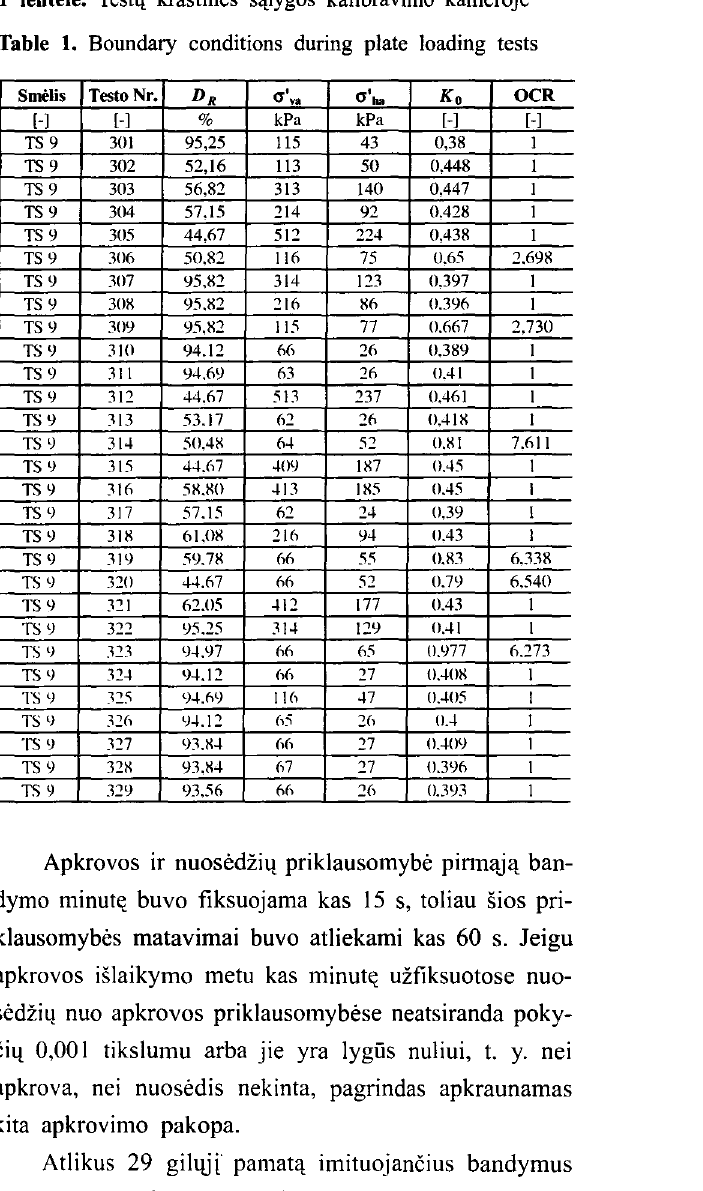
Table 1. Boundary conditions during plate loading tests Smelis Testo